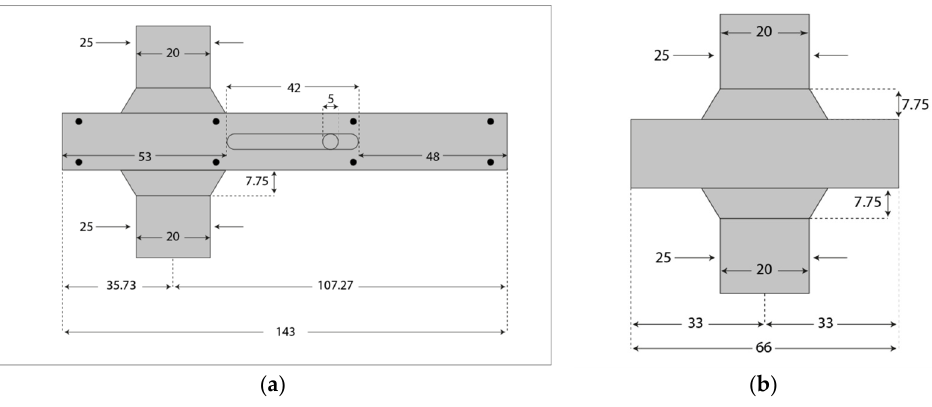
Figure 16. Third valve geometry. ( a ) Front view; ( b ) side view.